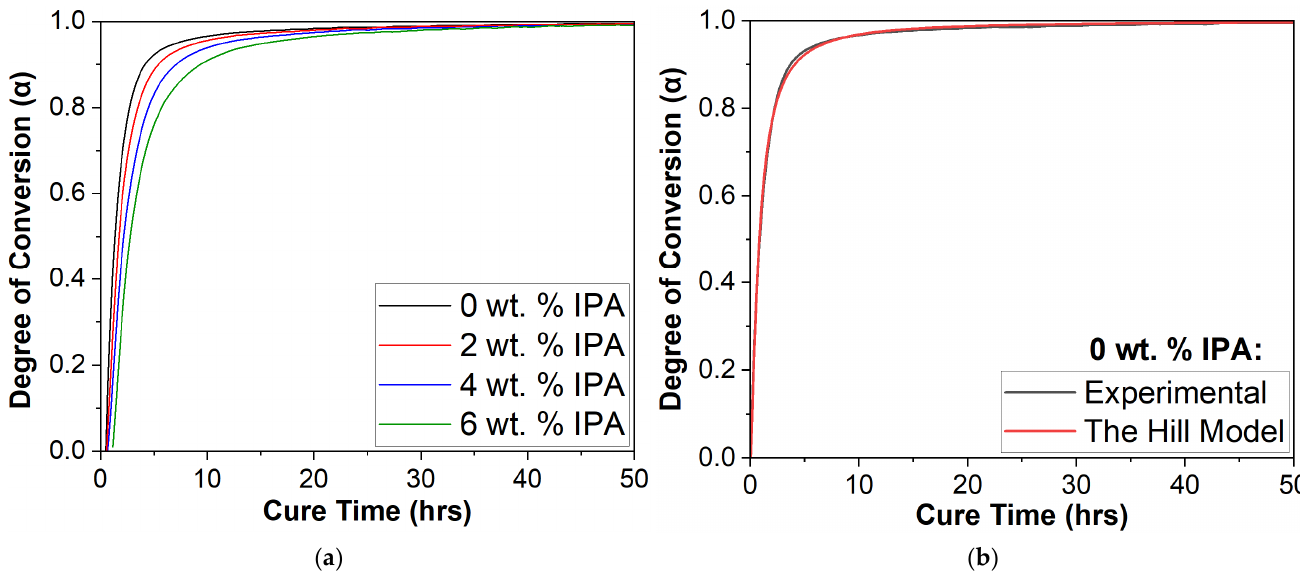
Figure 7. Degree of conversion with respect to cure time of ( a ) adhesive samples containing 0, 2, 4, and 6 wt.% of IPA; ( b ) experimental model using the Hill equation of the 0 wt.% IPA sample.